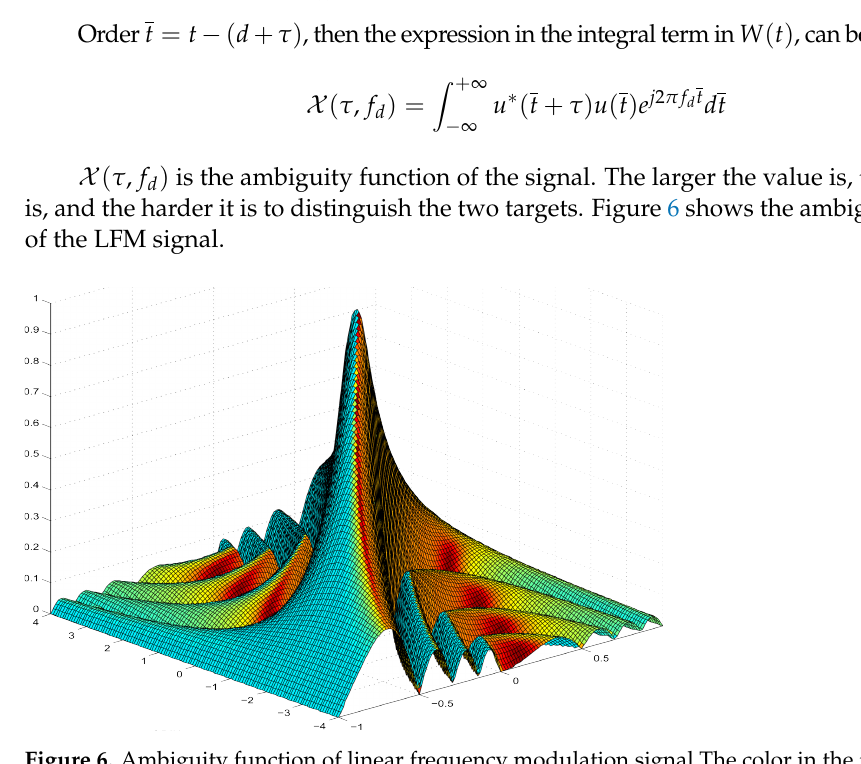
Figure 6. Ambiguity function of linear frequency modulation signal.The color in the figure does not affect the value of the fuzzy function, but only indicates whether it is directly on the Doppler